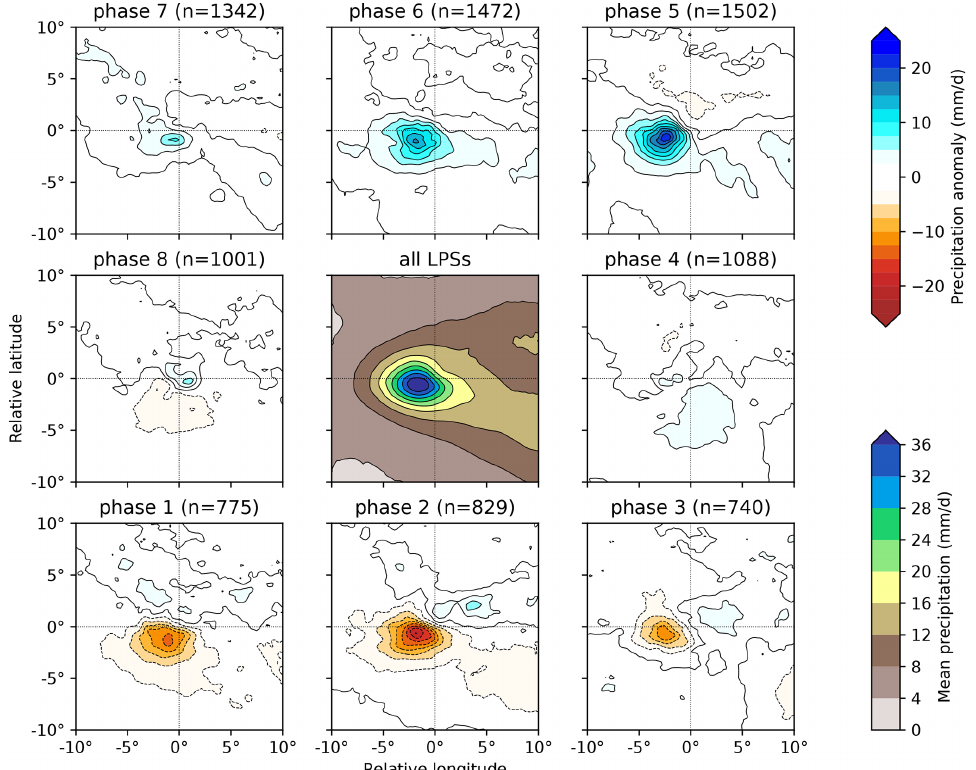
Figure 6. The effect of the BSISO on precipitation in monsoon LPSs north of 15 ◦ N. The central panel shows the mean composite system- centred precipitation for all such LPSs (including those in phase 0). Anomalies to this mean as a function of BSISO phase, along with their respective sample sizes (total 6-hourly time steps), are given in the surrounding panels. Precipitation data from